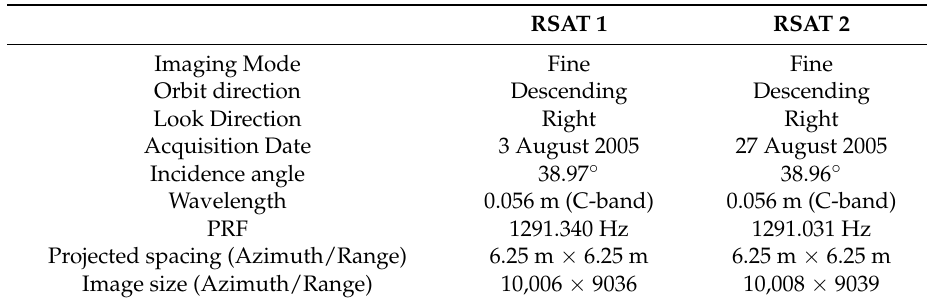
Table 2. Radarsat-1 (RSAT) image